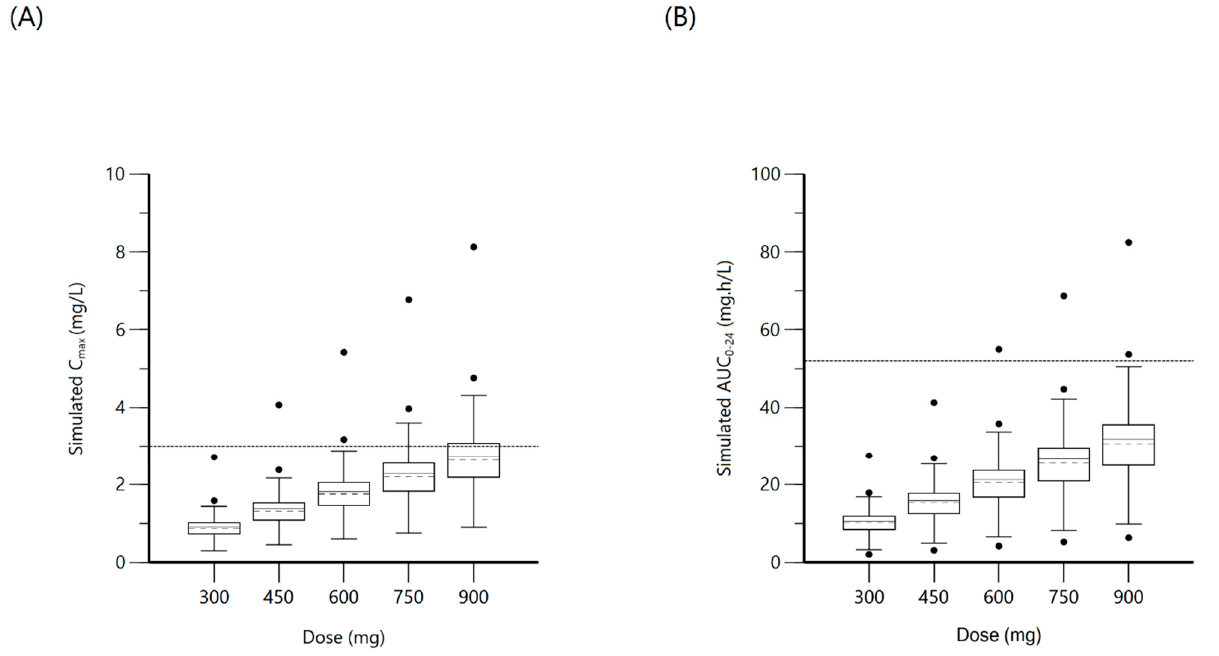
Figure 4. Plot ( A ) represents simulated isoniazid C max at various doses with the dashed line indicating the minimum threshold of 3 mg/L. Plot ( B ) represents simulated isoniazid AUC 0–24 at various doses with the dashed line indicating the minimum threshold of 52 mg.h/L.